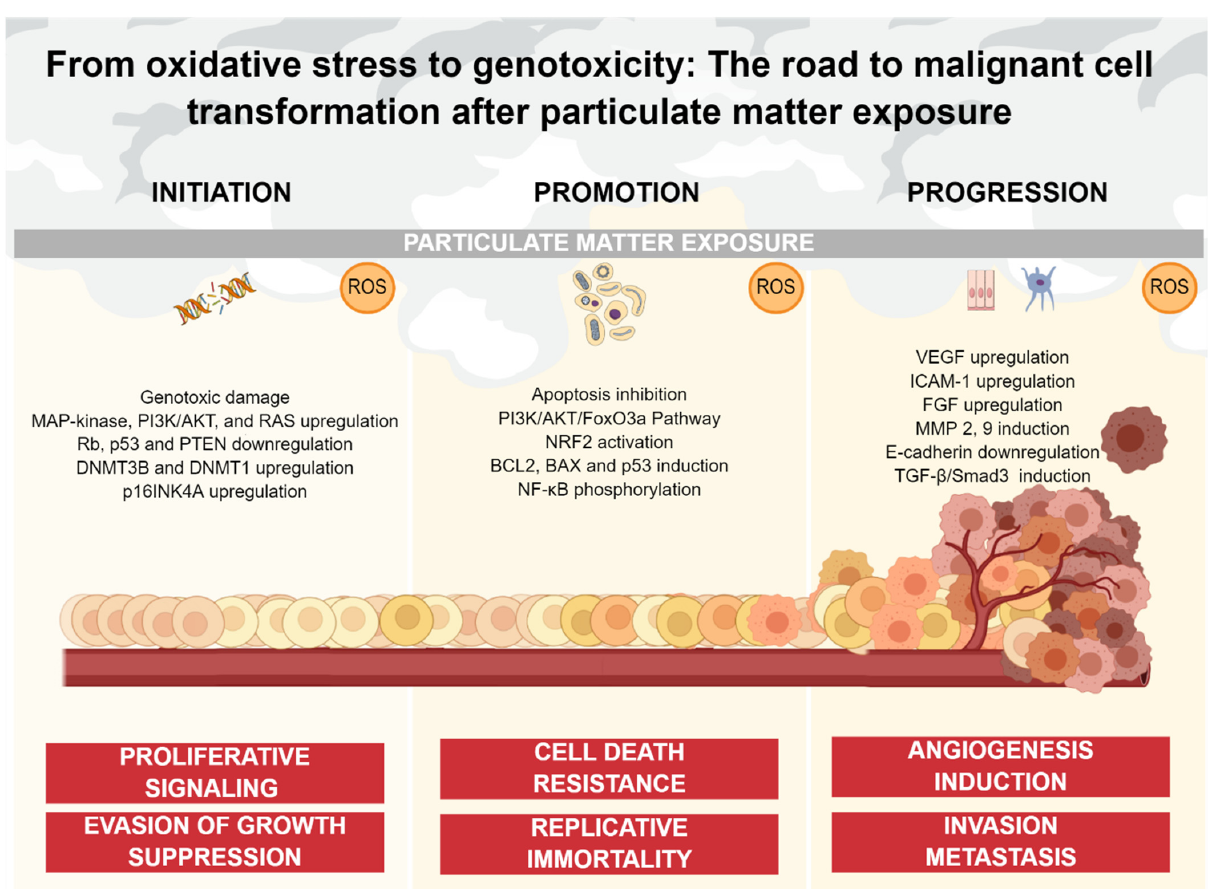
Figure 2. PM-mediated oxidative stress and its impact on cancer continuum. Oxidative stress caused by PM exposure is involved in multiple stages of the carcinogenic process. ROS can induce genotoxic damage, as well as non-genotoxic damage such as upregulation of oncogenic pathways and downregulation of tumor-suppressor components oriented to sustain proliferation and block anti-growth signals (initiation). ROS also inhibits apoptotic signaling through multiple pathways, promoting cell death resistance and replicative immortality (promotion). Finally, ROS upregulate multiple factors and pathways oriented to the acquisition of an invasive phenotype, as well as the generation of a blood vessel network from a pre-existing one